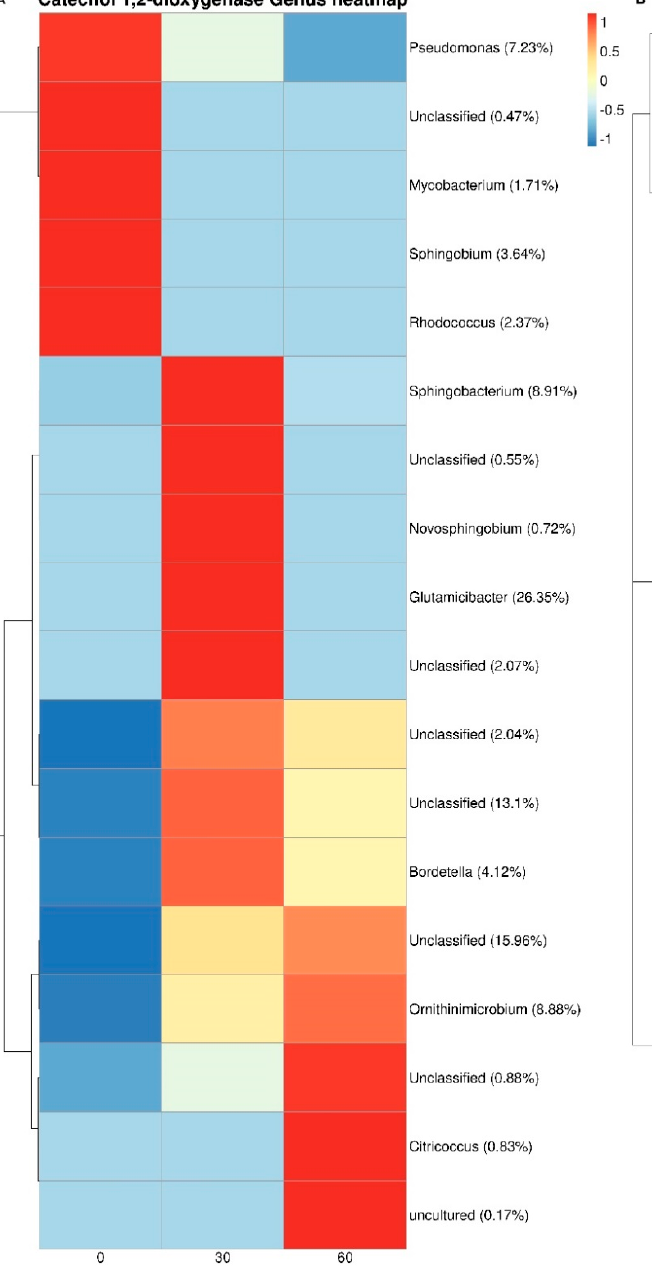
Figure 10. Functional heatmap for catechol 1,2- dioxygenase at genus level. Functional heatmap showing SMS community ( A ) and Lambertella sp. MUT 5852 community ( B ), genus contribution to catechol 1,2- dioxygenase (EC:1.13.11.1). Percentages reported near genus names represent the relative abundance of the sum of the contribution of that genus per sample, against the total sum of contributions: a cut-off value of 0.005% was chosen. Hierarchical clustering was performed on rows by Pearson correlation, based on Euclidean distance. In order to evidence variation, a colour scheme that represents row-wise Z-scores of per genus contributions per sample, was chosen. For this colour scheme, a Z value of 0 matches the reported percentage near the genus contributor.